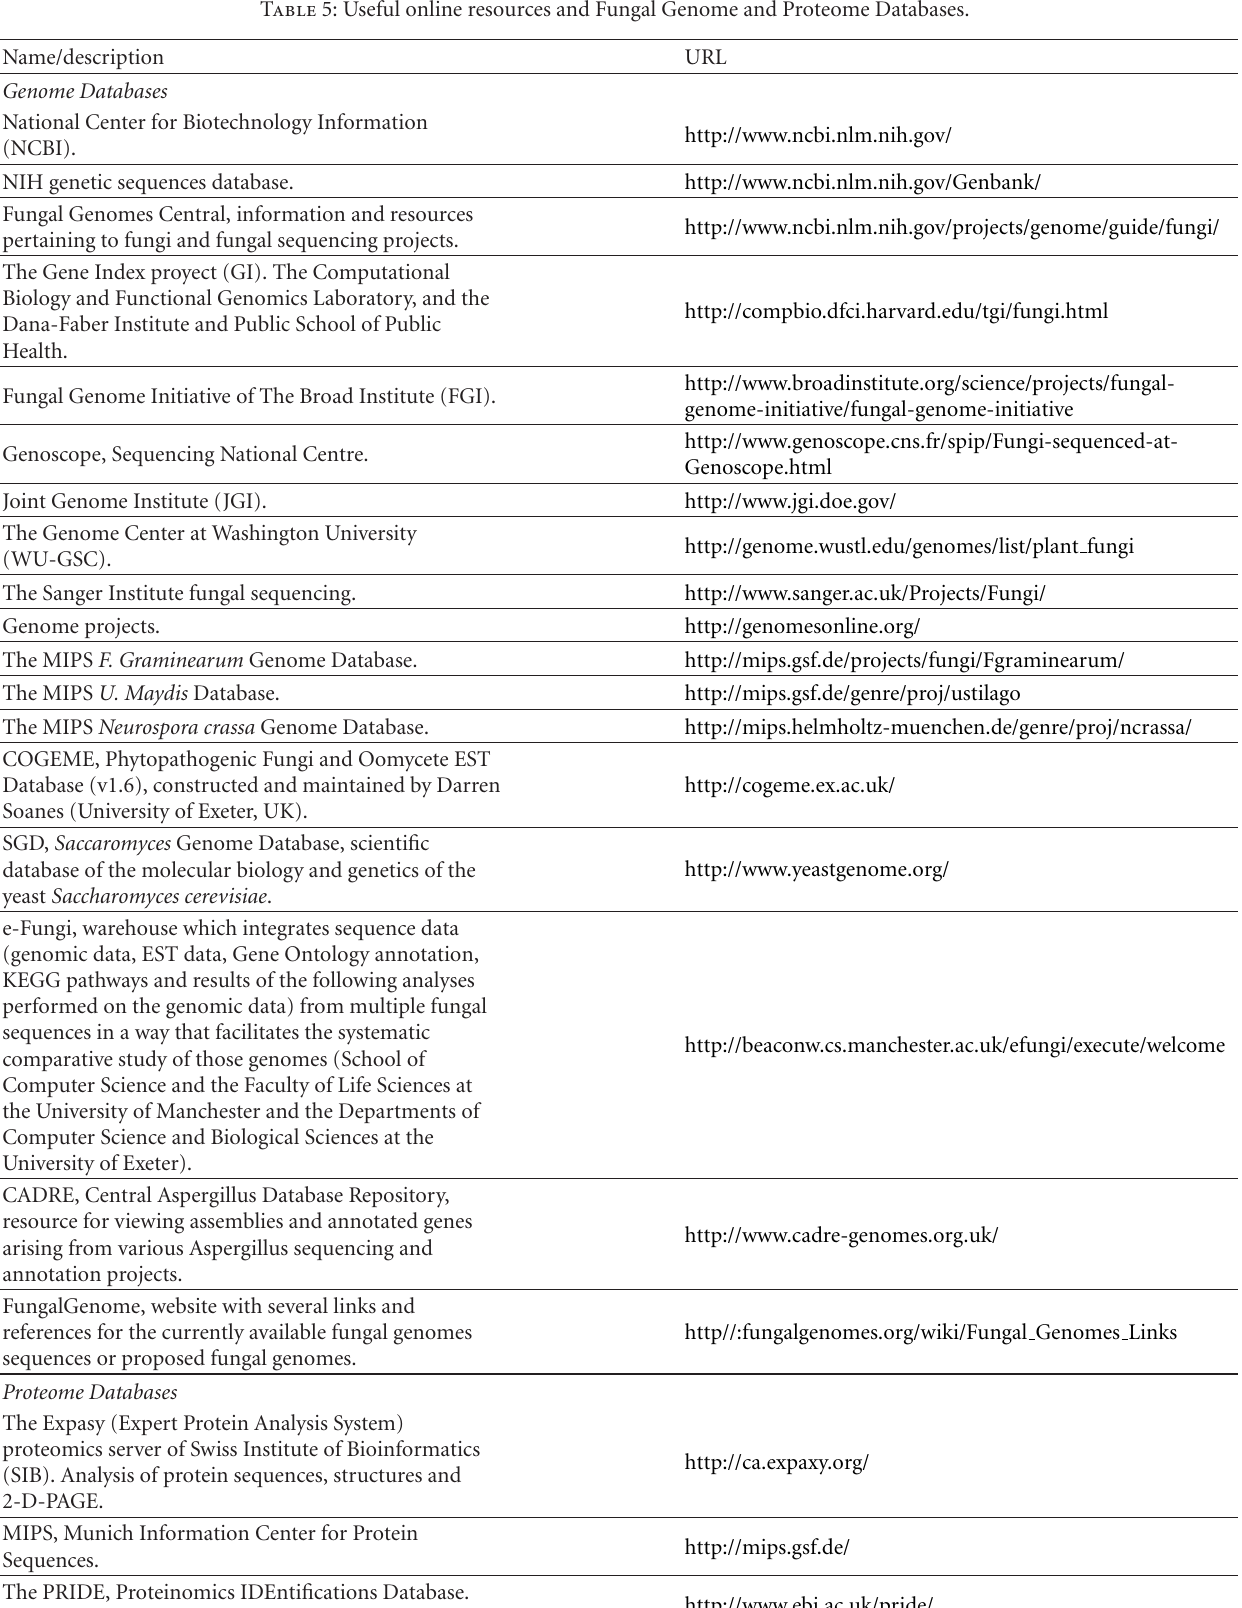
Table 5: Useful online resources and Fungal Genome and Proteome